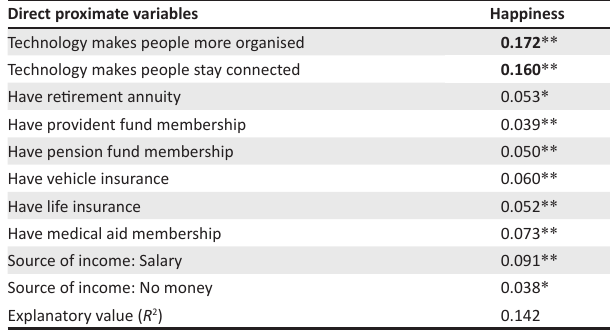
TABLE 8: Results of the sequential analysis regarding the proximate stochastic determinants of happiness.